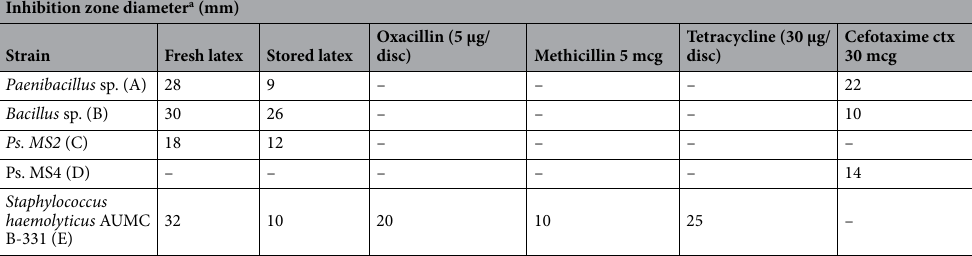
Table 2. Inhibition zone of antibacterial activity of fig latex against biofilm-forming bacteria isolated from DFUs. Fresh, fresh fig latex activity; stored, stored fig latex activity. Oxacillin, methicillin, tetracycline and cefotaxime are the antibiotics used as standard references, no activity; a Inhibition zone includes the well